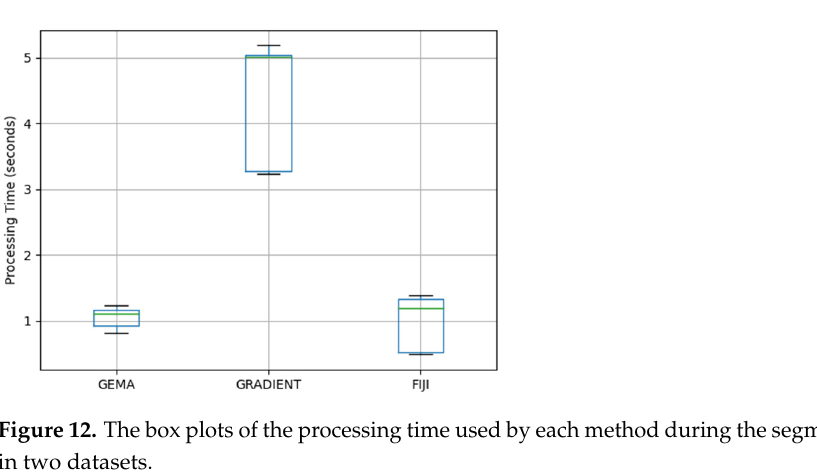
Table 3. A summary of statistical measures by each method according to the processing time.